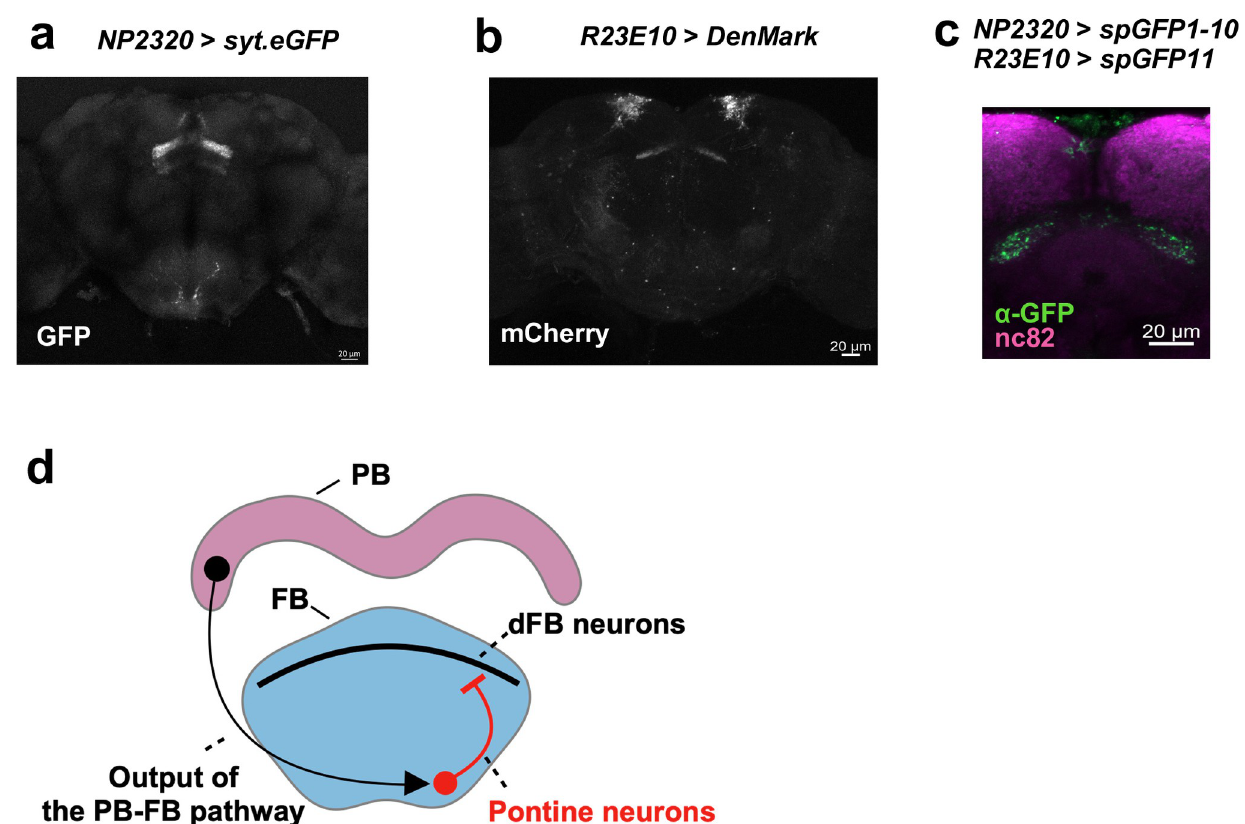
Fig 3. FB interneurons and dFB neurons form close associations. (a) Expression pattern of syt . eGFP in NP2320-labeled neurons. (b) Expression pattern of DenMark in R23E10-labeled neurons. (c) GRASP signals between dFB neurons labeled by R23E10 and FB interneurons labeled by NP2320. (d) Schematic diagram of the possible sleep-regulatory